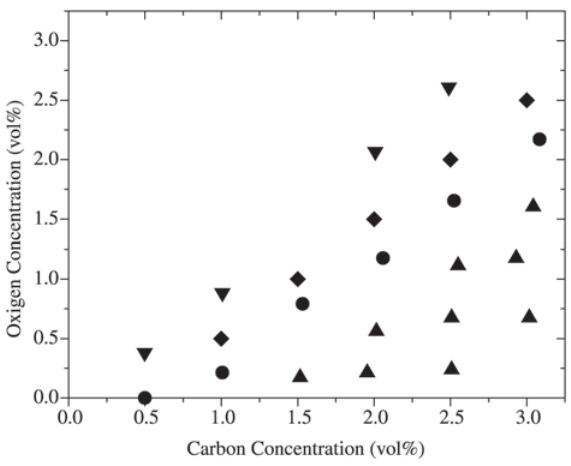
Figure 5. Summary of the growth regions as a function of carbon and oxygen concentrations in halocarbon/oxygen/hydrogen gas system. (cid:83) Non-diamond carbon; (cid:122) pour quality diamond; (cid:139) good quality diamond and (cid:84) no